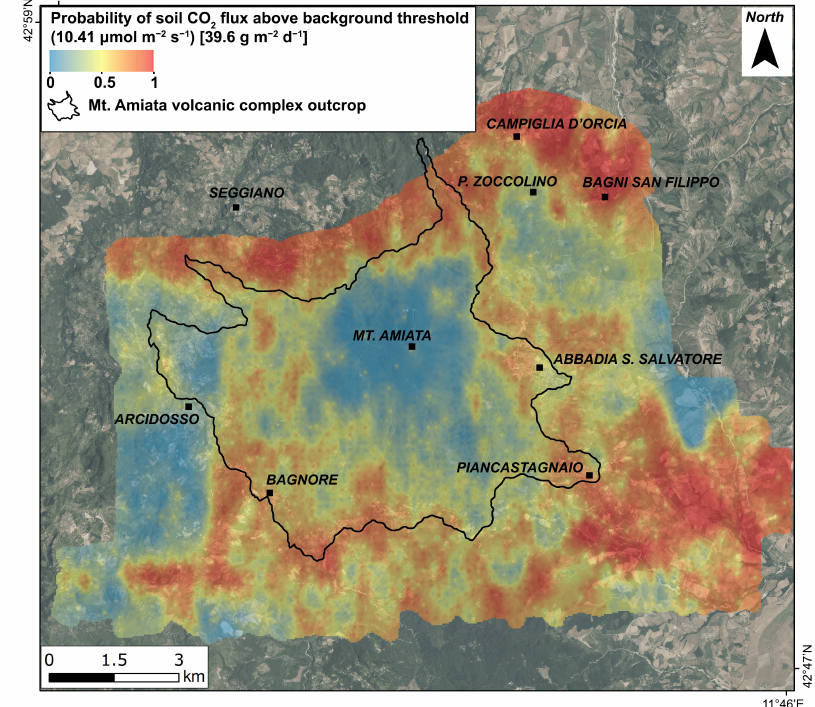
Figure 6. Probability map of occurrence of soil CO 2 flux higher than the background